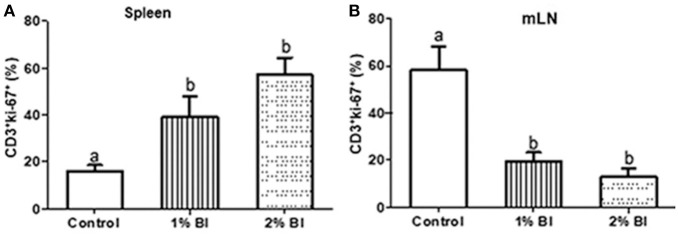
Effect of B. inquinans supplementation on T cell proliferation from splenocytes and mesenteric lymphocytes. On day 28, splenocytes and mesenteric lymphocytes were stimulated with plated-coated anti-CD3 (5 μg/ml) and soluble anti-CD28 (1 μg/ml) Abs to evaluate T cell proliferation pregated on CD3+ using flow cytometry. Values are means ± SEM (n = 6 mice/group). Means without a common letter differ at P < 0.05. Control, control diet; BI, B. inquinans.